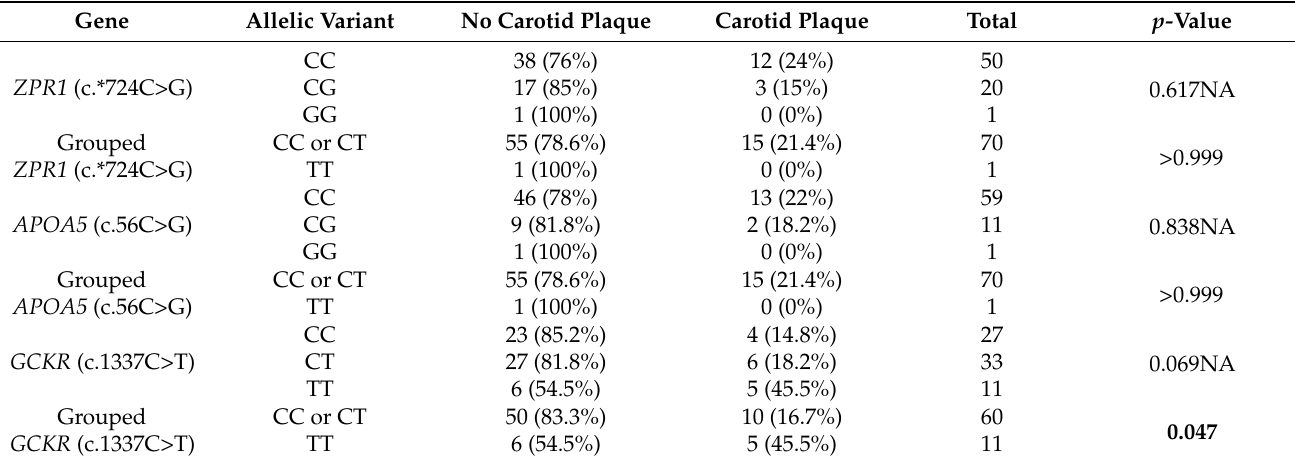
Table 4. Comparison of carotid plaque across